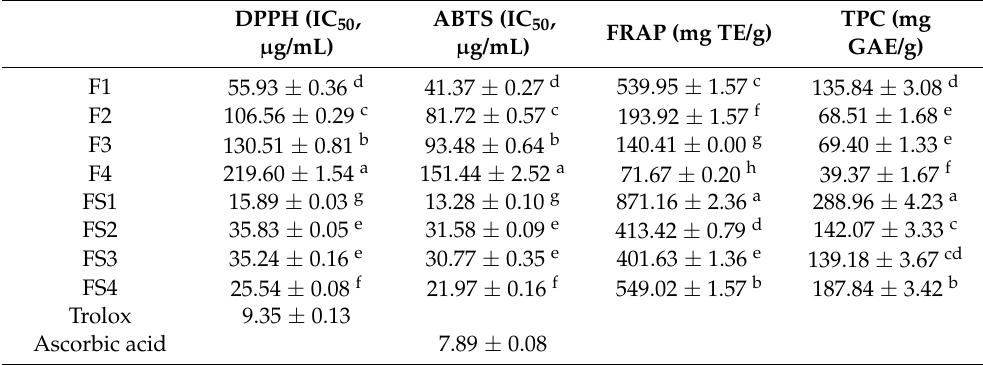
Table 3. Antioxidant activities and total phenolic contents of Cornus officinalis fruit extracts.